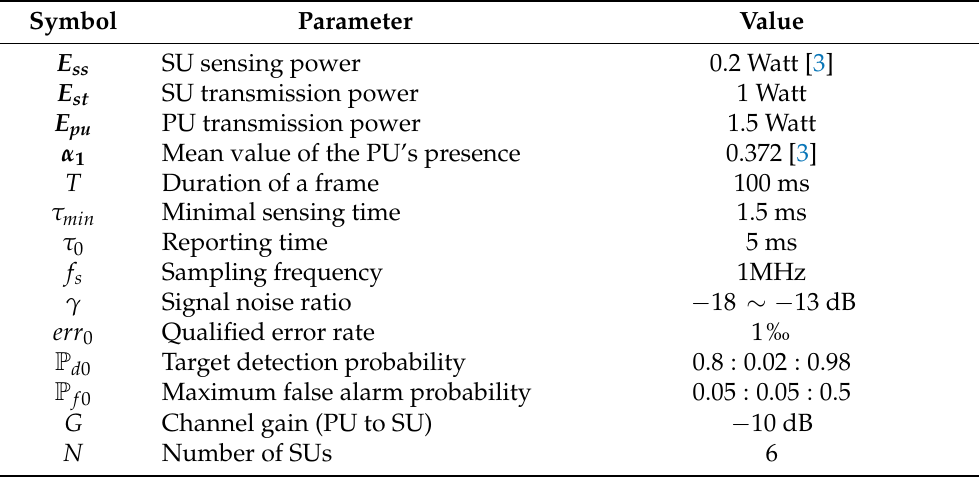
Table 3. Units for cognitive